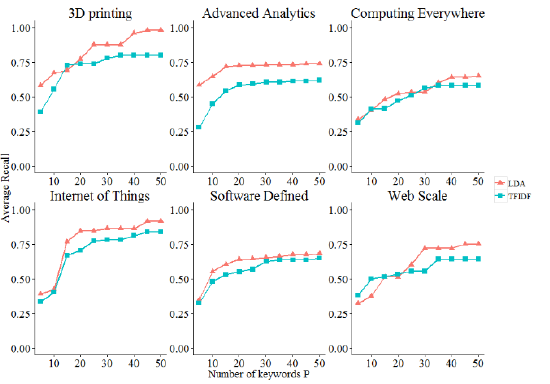
Fig. 9. Extracting Keyword Model Evaluation - Average F- measure in each category across the number of keywords (P) (red line: LDA, blue line: